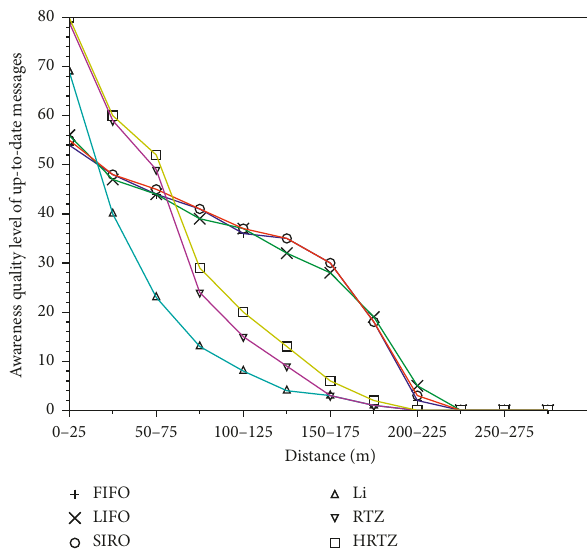
Figure 13: AQLU of receiving vehicles with respect to distances between